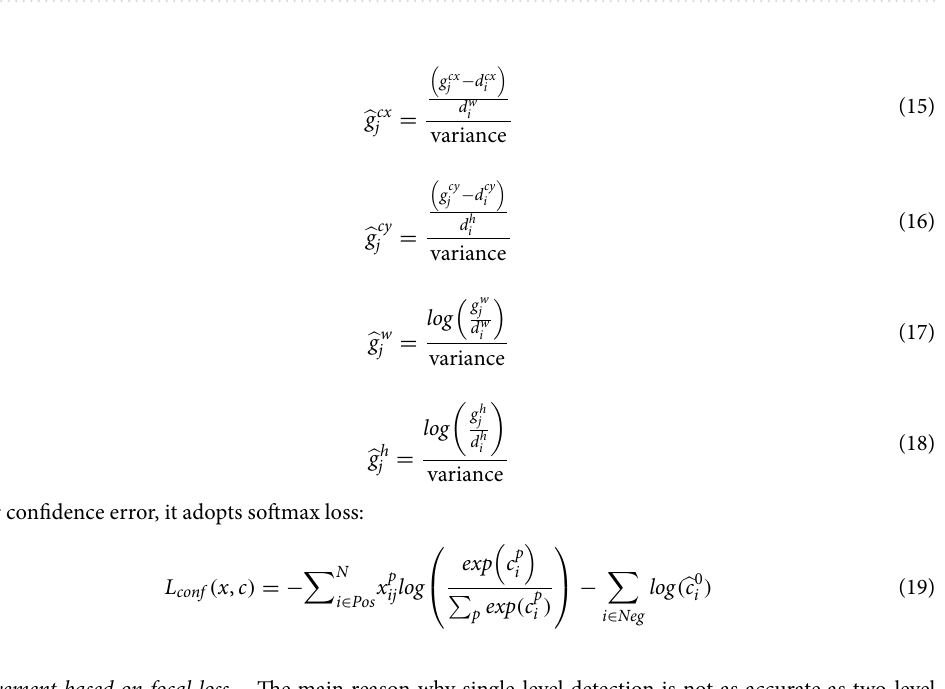
Figure 6. This figure fits the linear relationship between loss function and sample probability when r = 0, r = 0.5, r = 1, etc. Through it, we can clearly see the relationship between lost function numerical value and sample